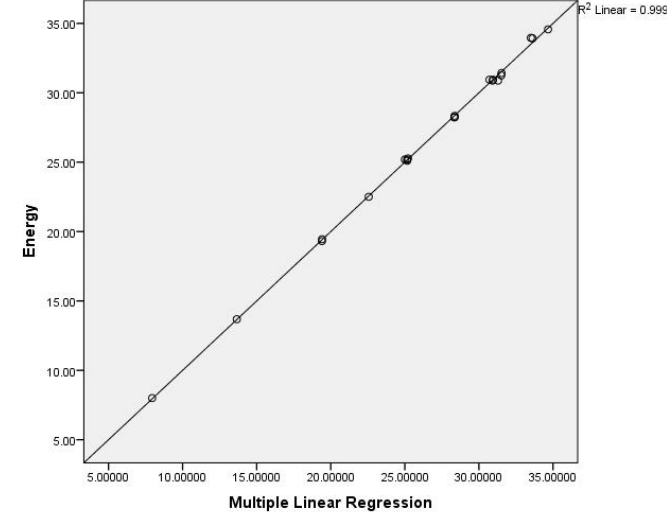
Figure 5. The multiple linear correlation for the energy of benzenoid